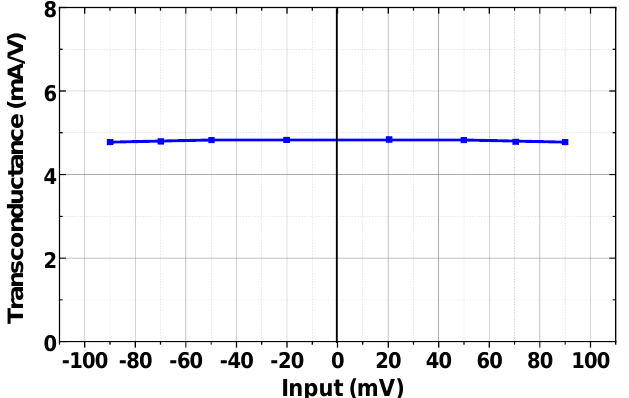
Figure 18. Measure transconductances as a function of input voltage.